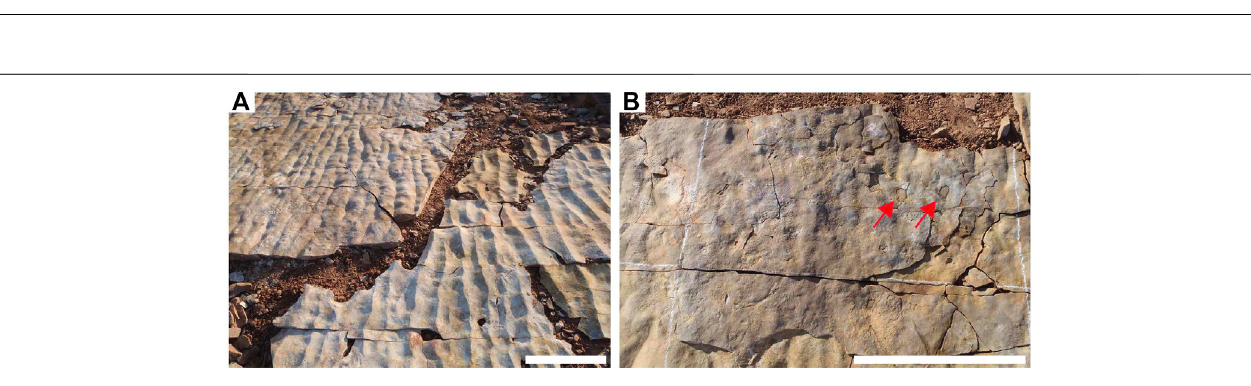
Frontiers in Earth Science |